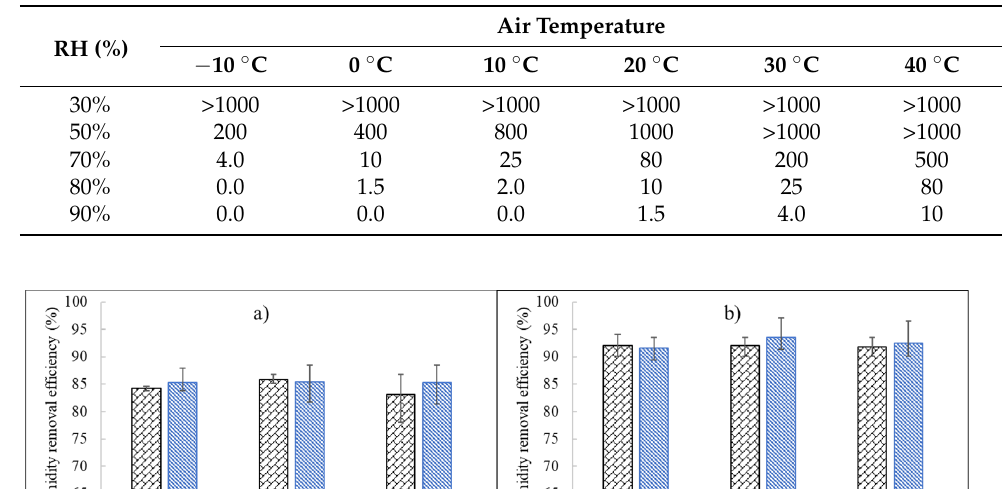
Figure 6. HCl loss rates of HPD_NP and HPD_NS with respect to various temperatures and other conditions: ( a ) low humidity (4%) and 5 ppmv HCl, ( b ) high humidity (17%) and 5 ppmv HCl, ( c ) low humidity (4%) and 10 ppmv HCl, and ( d ) high humidity (4%) and 10 ppmv HCl.